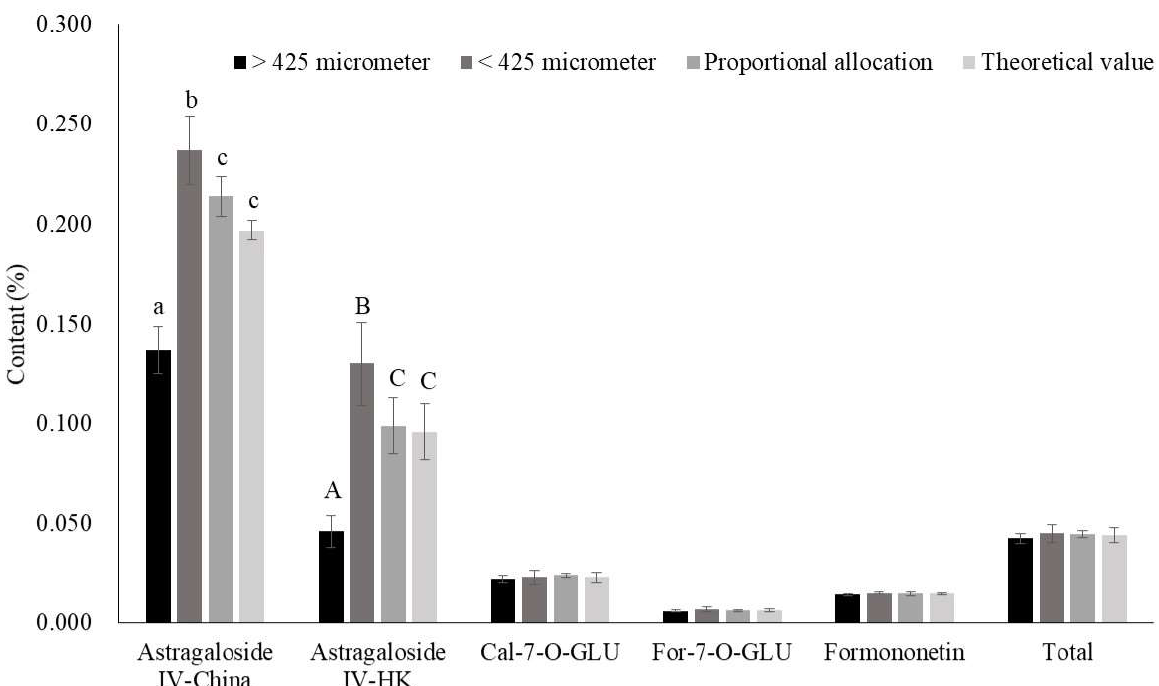
Figure 3. Effects of powder particle size on the content of Astragaloside IV and flavonoids in Astragali radix with a diameter of 0.3–0.6 cm. Data are expressed as mean ± SD from three separate